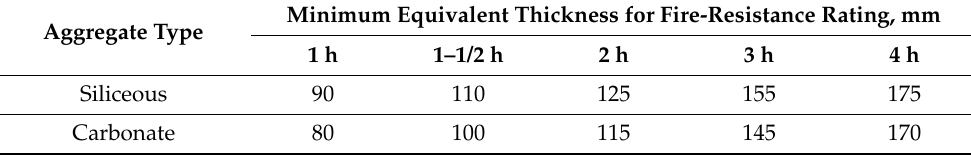
Table 6. Fire resistance of single-layer concrete walls, floors, and roofs (ACI 216.1M-14 [18]).